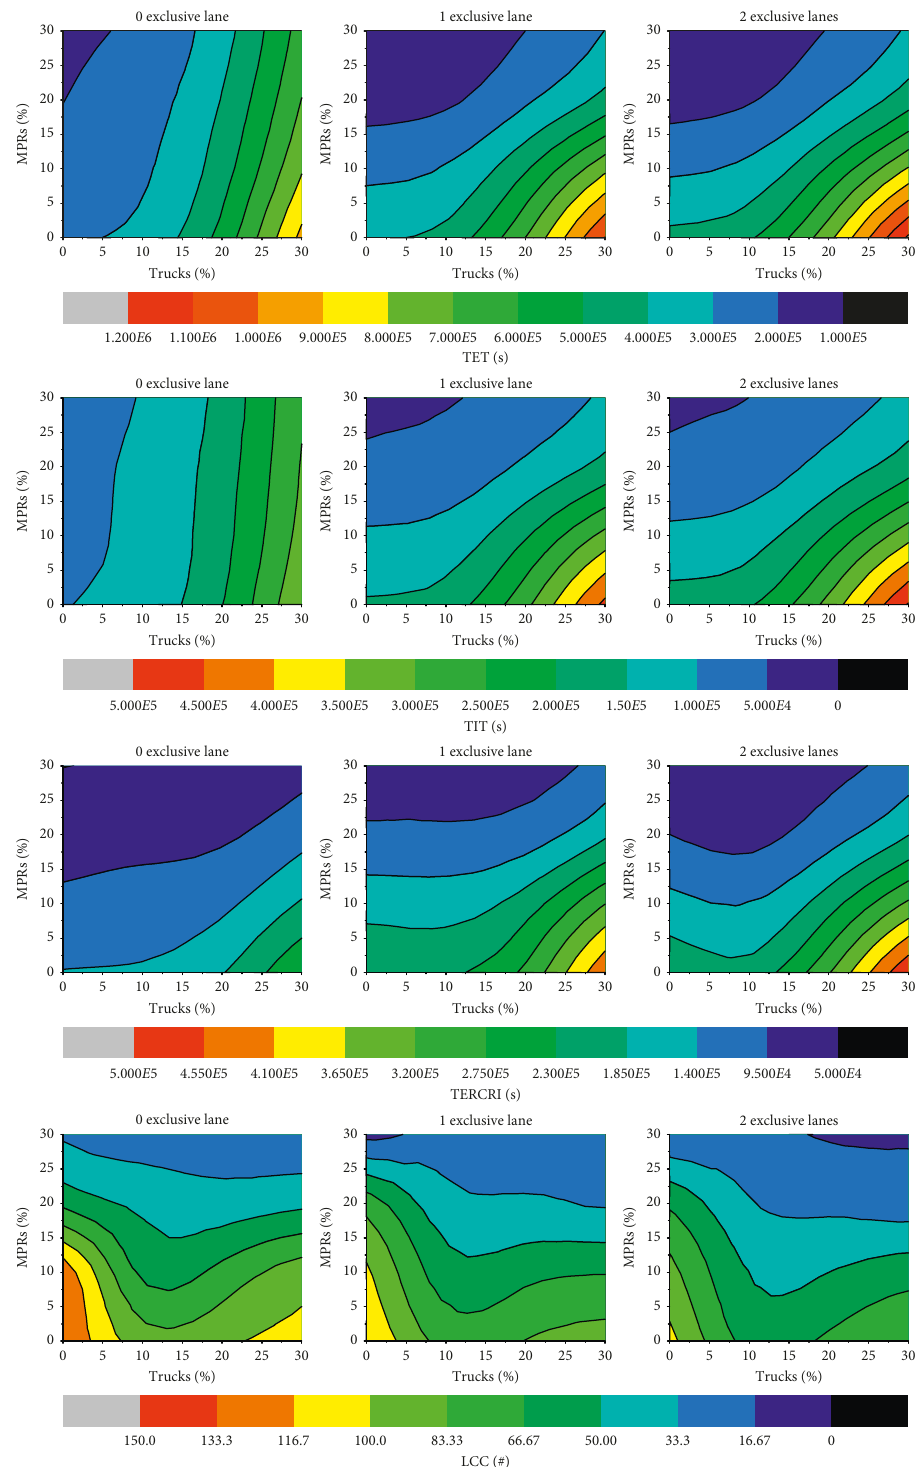
Figure 4: Safety evaluation results of CAV’s exclusive lane on volume �